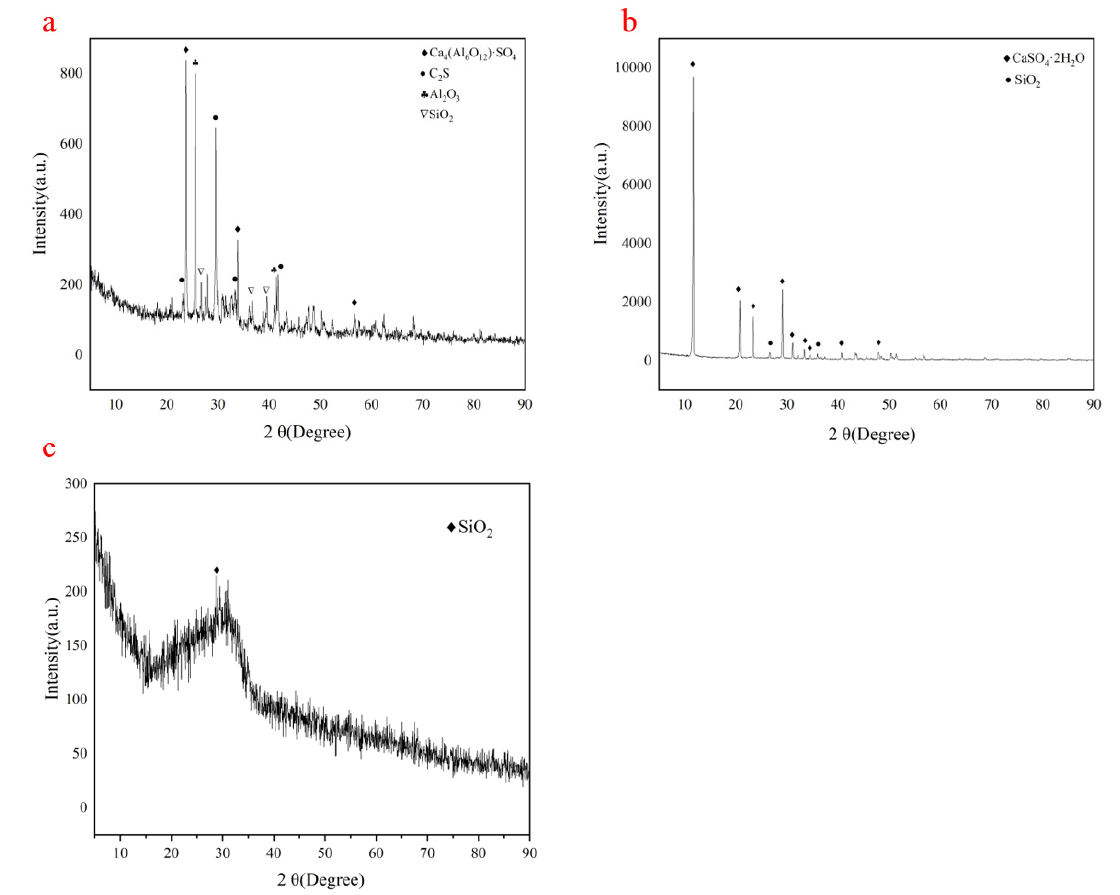
Figure 1. XRD patterns of sulphoaluminate cement ( a ), phosphogypsum ( b ) and granulated ground blast slag ( c ). Table 2. Performance test results of sulphoaluminate cement.